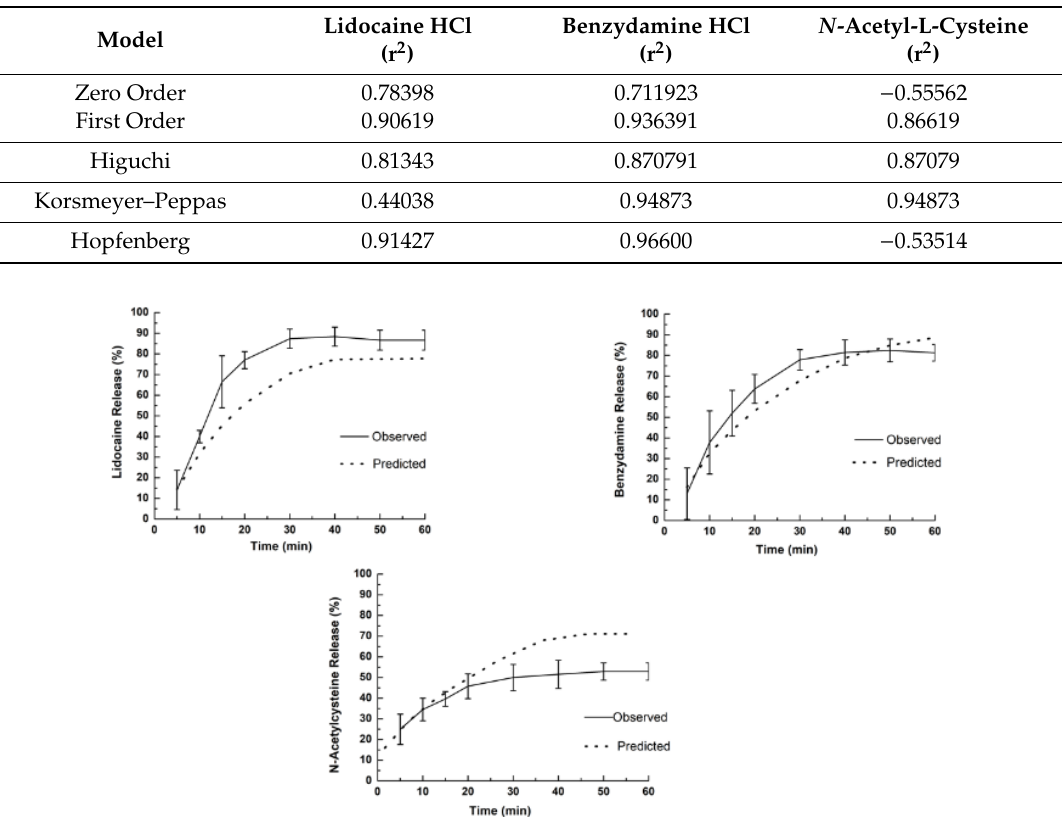
Figure 8. Release profiles observed (solid line) and predicted (dash line) for lidocaine HCl, benzydamine HCl, and N -acetyl-L-cysteine from A-film. The dashed lines in the release profile graphs show the values predicted and suitable for better mathematical models (Korsmeyer–Peppas or